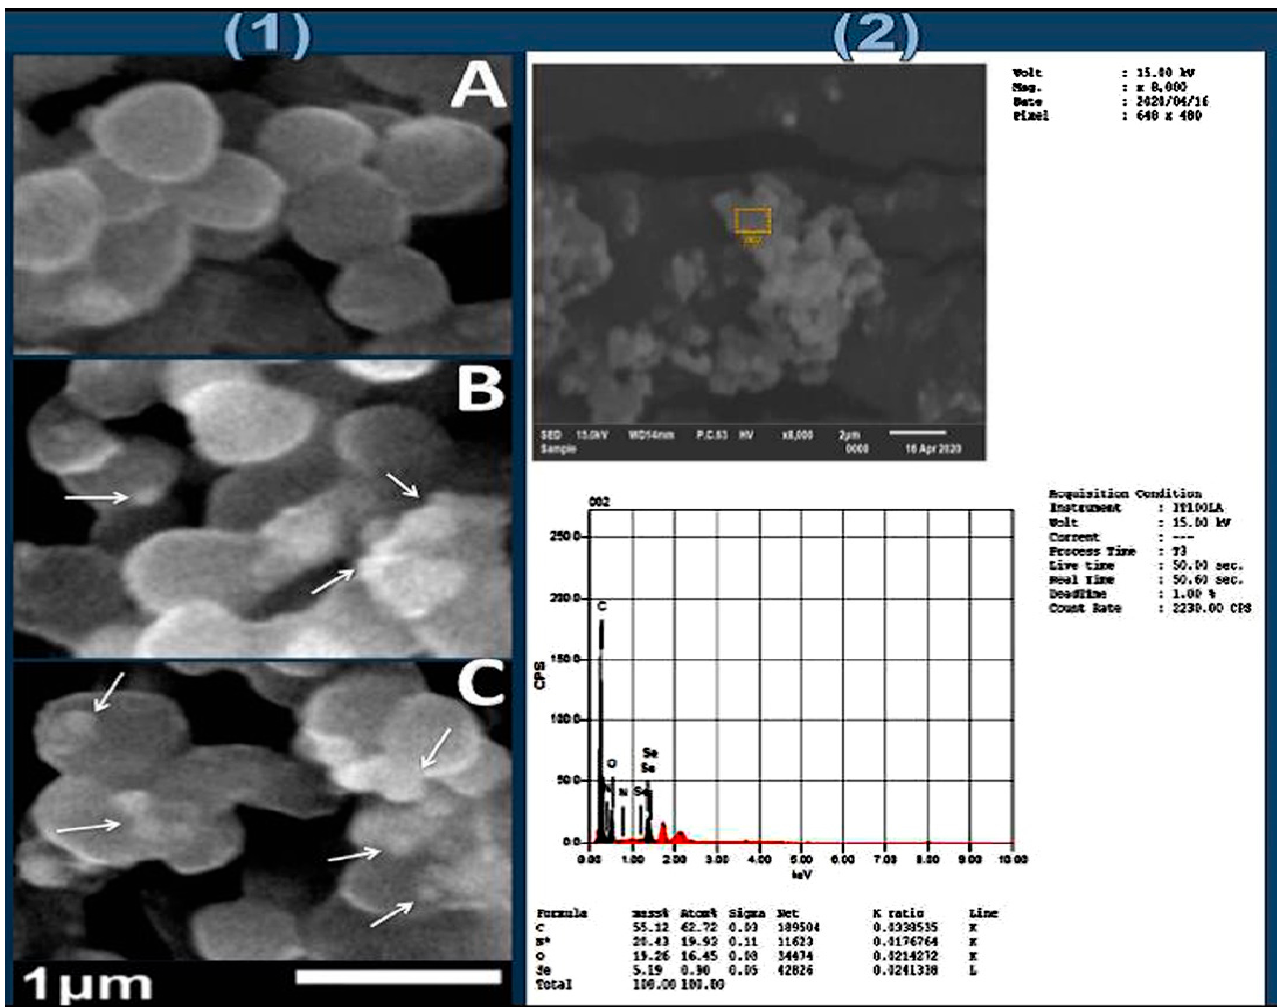
Figure 5. SEM ( 1 ) and EDS ( 2 ) of treated Staphylococcus aureus with BCht/Pro/SeNPs for 5 h ( 1-B ) and 10 h ( 1-C ) compared with control cells ( 1-A ) .